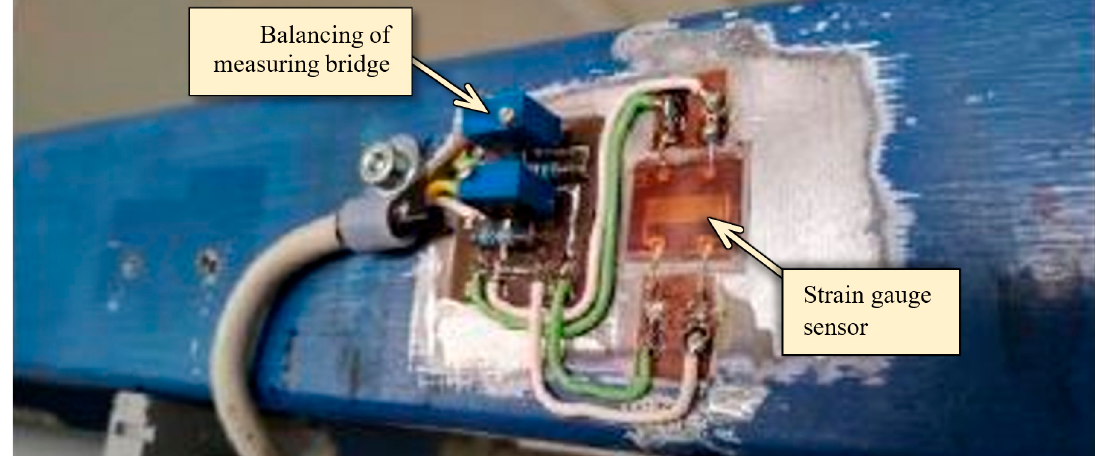
Figure 8. Application of the strain gauge sensors on the given bridge crane.